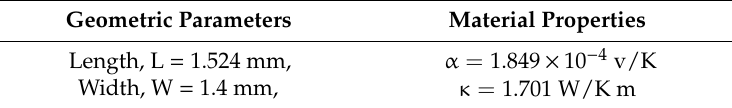
Table 3. Geometric dimensions and material properties [47] 2017, B. L.